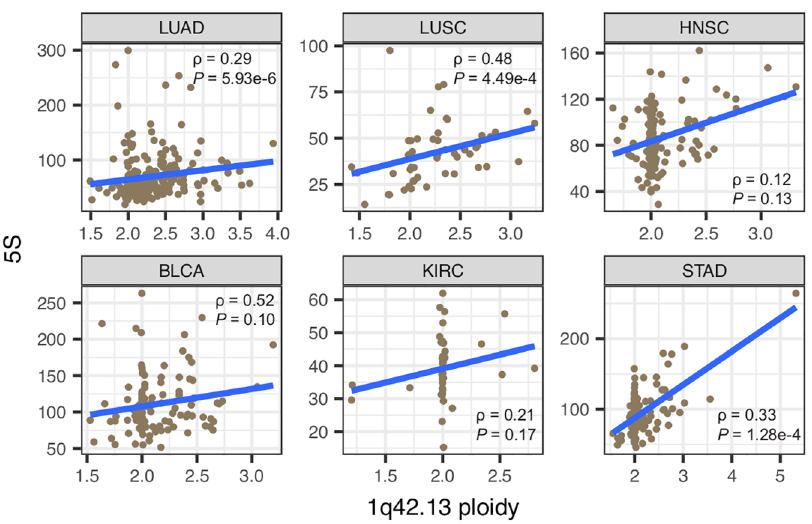
Fig 5. Increased 1q42.13 ploidy partially explains increased 5S rDNA CN in cancers. In each cancer type, all availabletumors were included. Spearman’s rank correlationwas